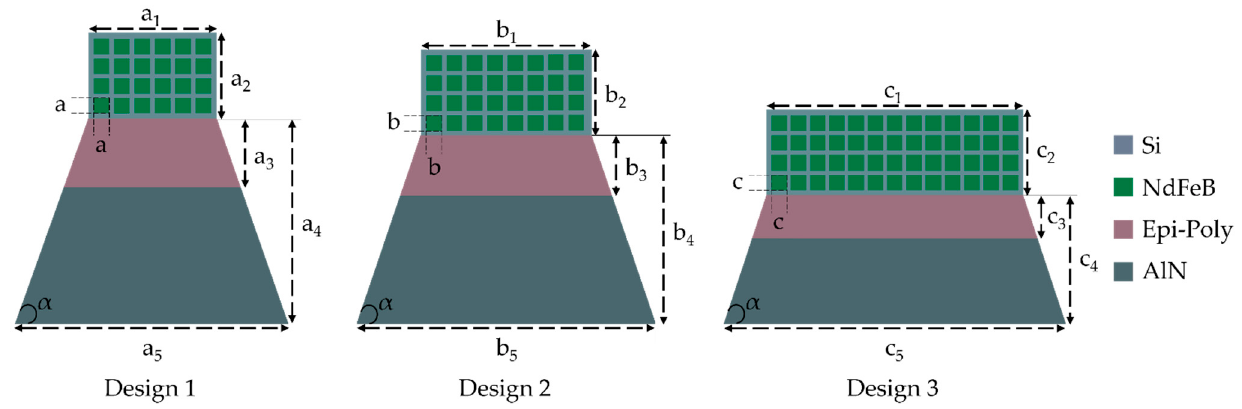
Figure 3. Schematic top view of the piezoelectric energy harvester designs with integrated NdFeB micromagnet arrays (corresponding cross-sections given in Figure 2). The angle α = 70° is kept constant in all designs.